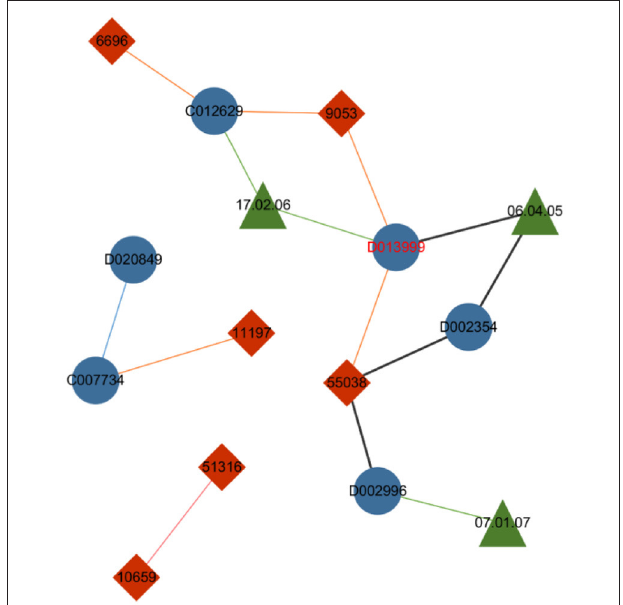
FIGURE 4 | Drug–gene–ADR network. The blue nodes indicate drugs, the red nodes indicate genes, and the green nodes indicate ADRs. The green lines between drug nodes and ADR nodes indicate the caused association of a drug–ADR pair, and the orange lines illustrate the interactive association between drugs and genes. The blue and pink lines indicate the similarity between two drugs and two genes